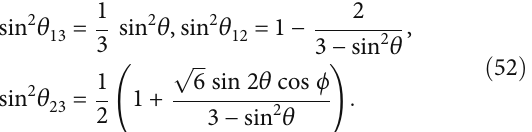
σ C.L. (only neutrino oscillation data are